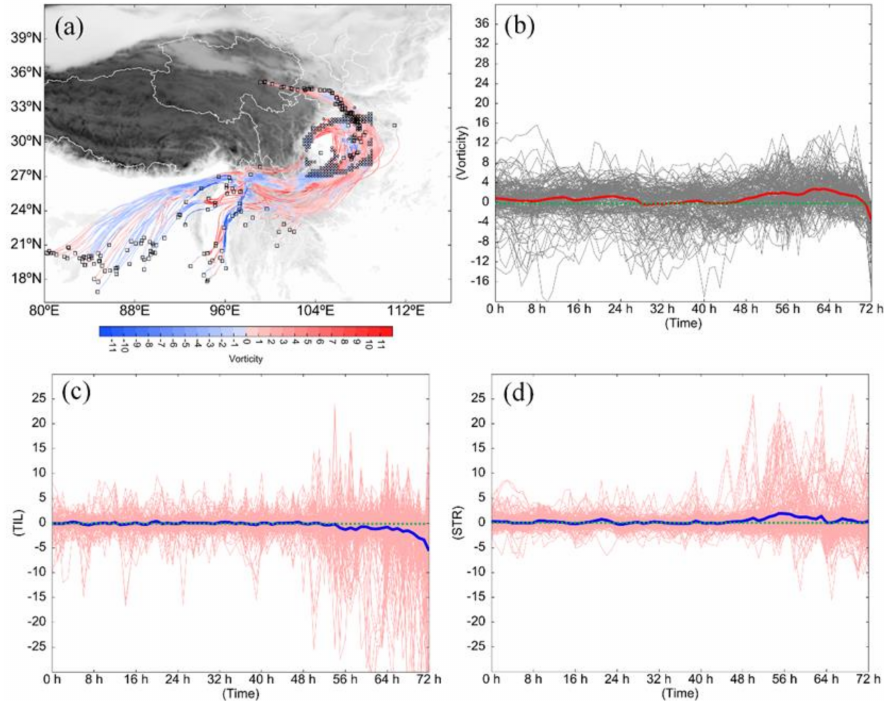
Figure 5. Panel ( a ) shows the backward (from 1800 UTC 26 to 1800 UTC 23 June 2020) trajectories and vorticity (shading, units: 10 − 5 s − 1 ) of the air particles that belong to the Neg type, where black boxes/circles show the initial/final locations of the air particles. Panel ( b ) shows the vorticity variations of the NEG-type trajectories (units: 10 − 6 s − 1 ). Panels ( c , d ) show the budget terms TIL and STR of the NEG-type trajectories, respectively (units: 10 − 10 s − 2